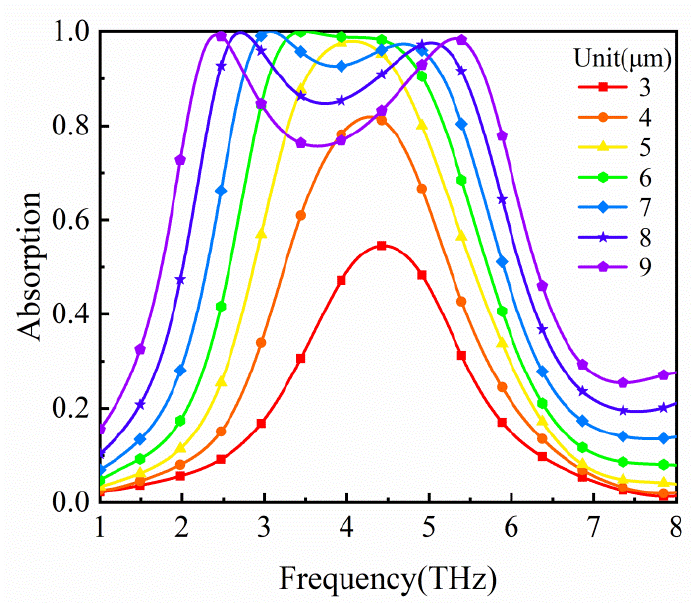
Figure 5. Absorption spectra of the absorber for different graphene side lengths.